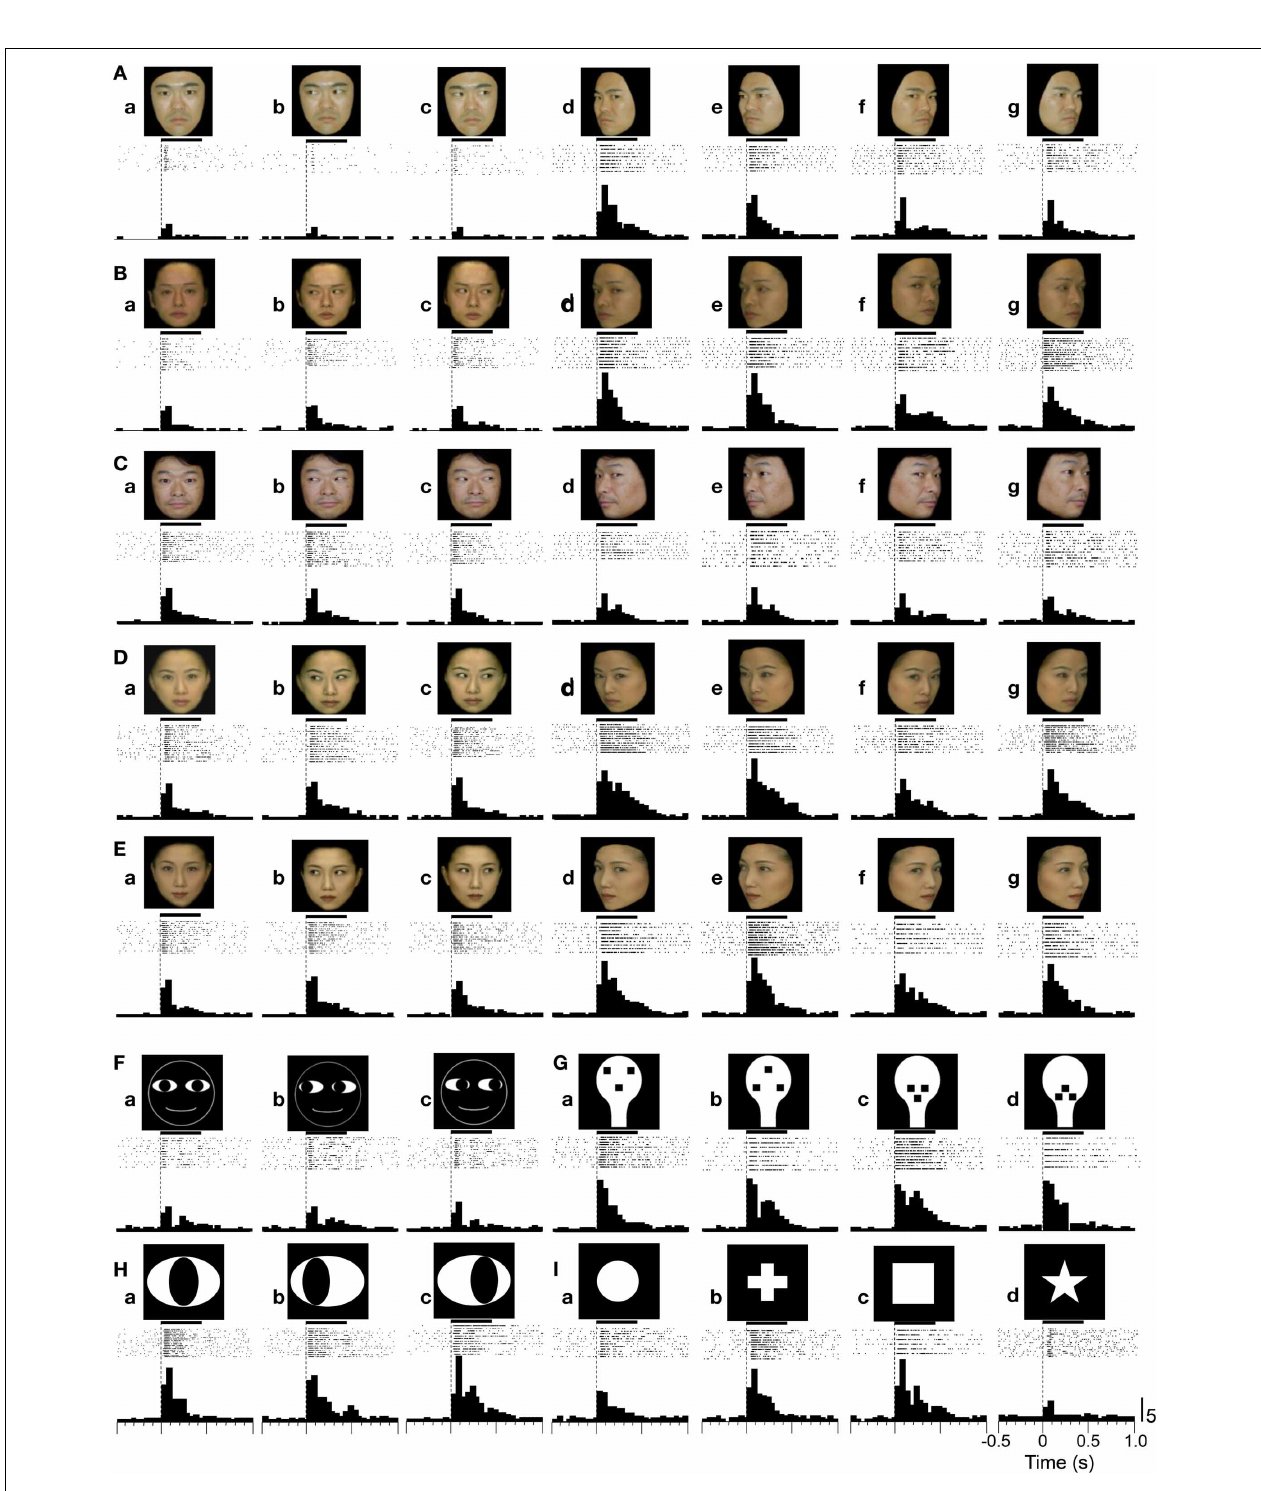
FIGURE 4 | An example of a superficial SC (sSC) neuron that responded to the visual stimuli. (A–E) Responses to the facial photos. (F–I) Responses to the face cartoons (F) , face-like patterns (G) , eye-like patterns (H) , and simple geometric patterns (I) . Horizontal bars above the raster displays